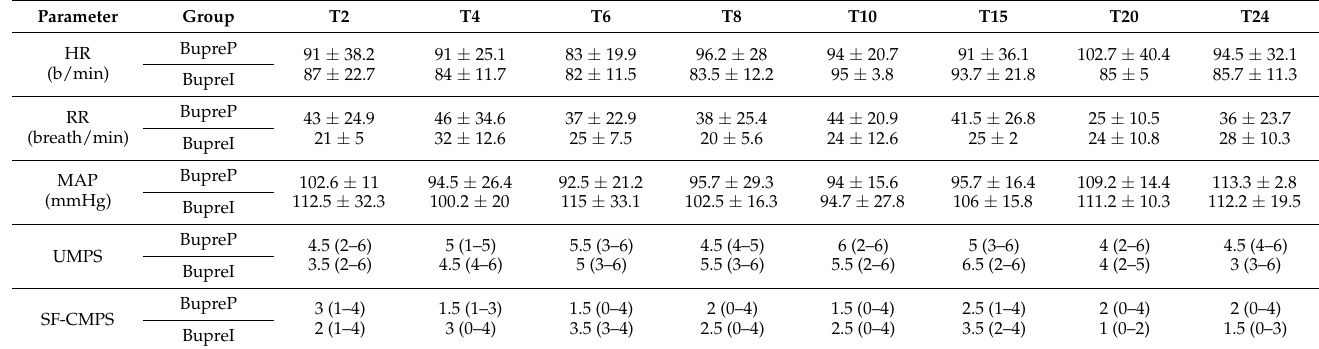
Table 4. Mean ± SD of physiological parameters and median (min–max) of the pain scores at 2, 4, 6, 8, 10, 15, 20, and 24 h after extubation (T2, T4, T6, T8, T10, T15, T20, and T24,